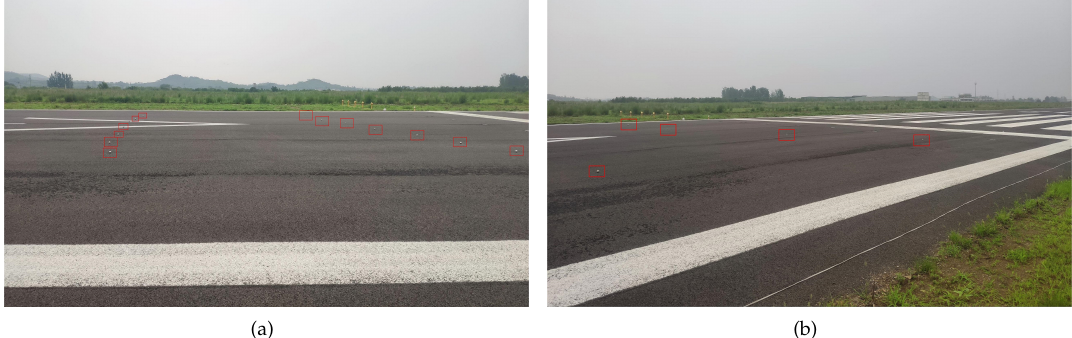
Figure 8. The golf balls placement on the pavement scene. Since the targets are too small in the image, they are highlighted in red rectangular boxes.